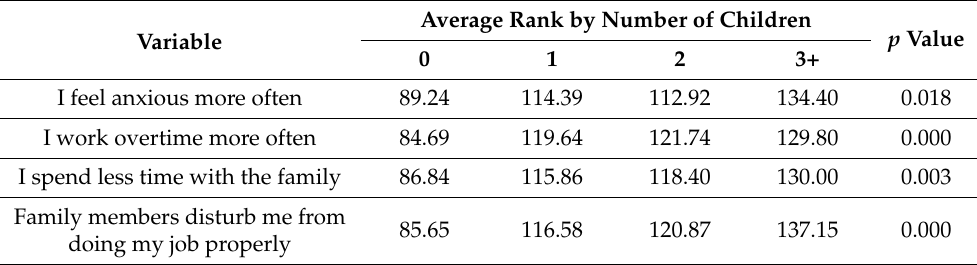
Table 3. The effect of teleworking by the number of